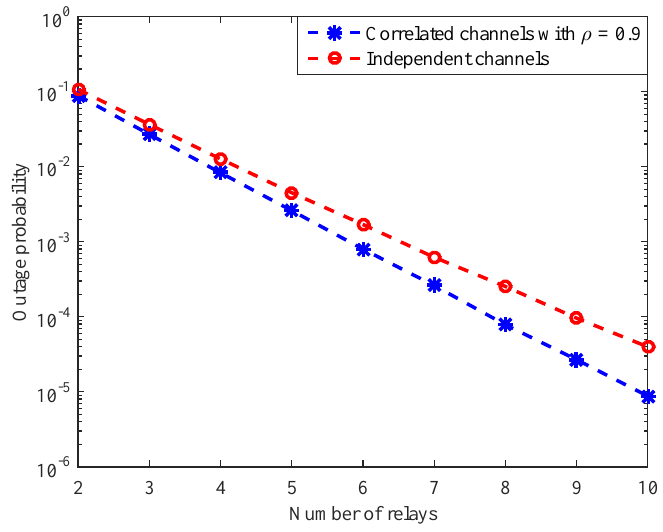
Figure 6. System outage probability versus the number of relays at 20 dB average SNR.